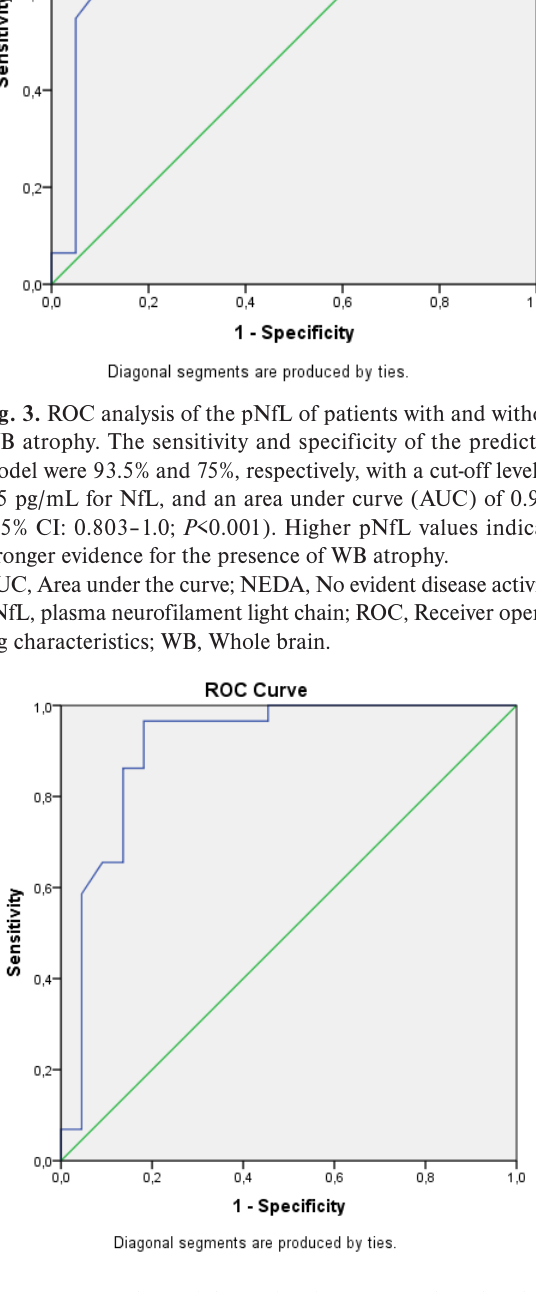
Fig. 4. ROC analysis of the pNfL of patients with and without GM atrophy. The sensitivity and specificity of the predictive model were 71.9% and 73.7%, respectively, with a cut-off level of 9.55 pg/mL for NfL, and an area under curve (AUC) of 0.738 (95% CI: 0.587–0.809; P <0.01). Higher pNfL values indicate stronger evidence for the presence of GM atrophy.